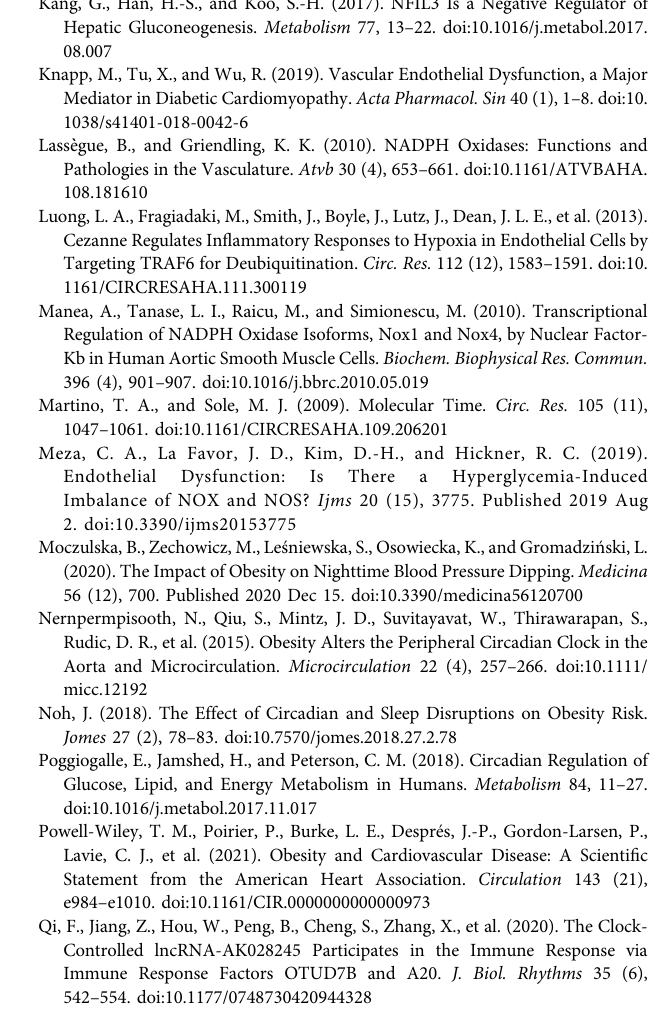
Supplementary Figure S2 | Plasma reactive oxygen species. Plasma levels of thiobarbituric acid reactive substances in male 20-week old lean (db/+ ) and obese ( db/db) mice with and without exposure to constant darkness ( n =5). All data are represented as mean ± SEM. Supplementary Figure S3 | Total qPCR of all mouse cohorts. (A) . eNOS mRNA levels in freshly isolated mesenteric endothelial cells from male 20-week old lean (db/+ ) and obese ( db/db) mice with and without constant darkness ( n =3 – 6). (B) . NOX1 mRNA levels in freshly isolated mesenteric endothelial cells from male 20- week old lean (db/+ ) and obese ( db/db) mice with and without constant darkness ( n =3 – 6). (C) . BMAL1 mRNA levels in freshly isolated mesenteric endothelial cells from male 20-week old lean (db/+ ) and obese ( db/db) mice with and without constant darkness ( n =3 – 6). (D) . PER2 mRNA levels in freshly isolated mesenteric endothelialcellsfrommale20-weekoldlean (db/+ )andobese( db/db) micewithand without constant darkness ( n =3 – 6). (E) . DBP mRNA levels in freshly isolated mesenteric endothelial cells from male 20-week old lean (db/+ ) and obese ( db/db) mice with and without constant darkness ( n =3 – 6). (F) . RevErb α mRNA levels in freshly isolated mesenteric endothelial cells from male 20-week old lean (db/+ ) and obese ( db/db) mice with and without constant darkness ( n =3 – 6). (G) . NFIL3 mRNA levels in freshly isolated mesenteric endothelial cells from male 20-week old lean (db/+ ) and obese ( db/db) mice with and without constant darkness ( n =3 – 6). (H) .CezannemRNAlevelsinfreshlyisolatedmesentericendothelialcellsfrom male 20-week old lean (db/+ ) and obese ( db/db) mice with and without